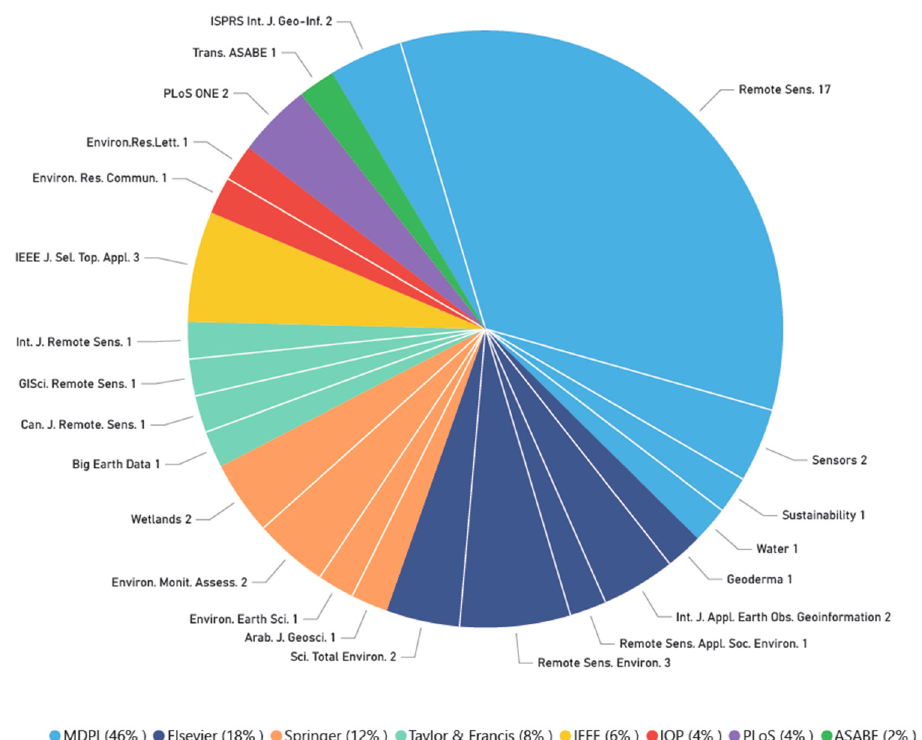
Figure 3. Publisher and journal contributions to the studies included in this SLR.